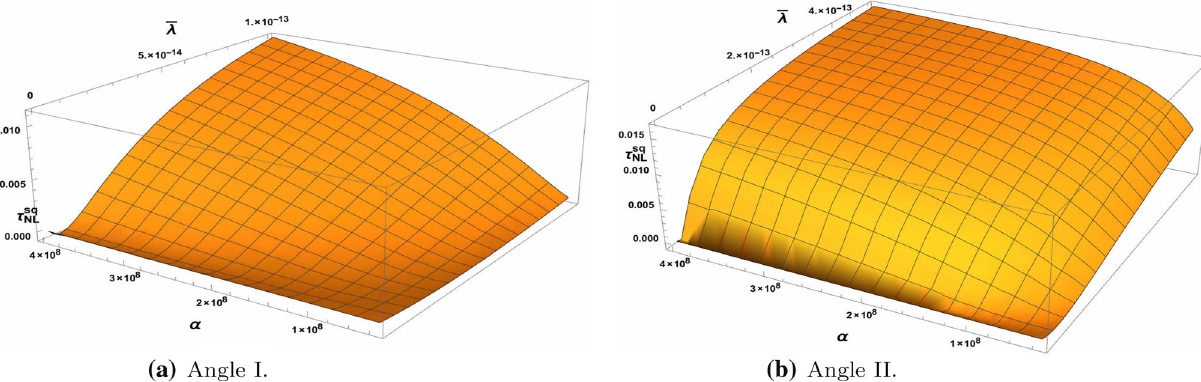
Fig. 31 Representative 3D diagram for equilateral non-Gaussian three point amplitude vs. the model parameters α and ¯ λ for N cmb = 60 in two different angular